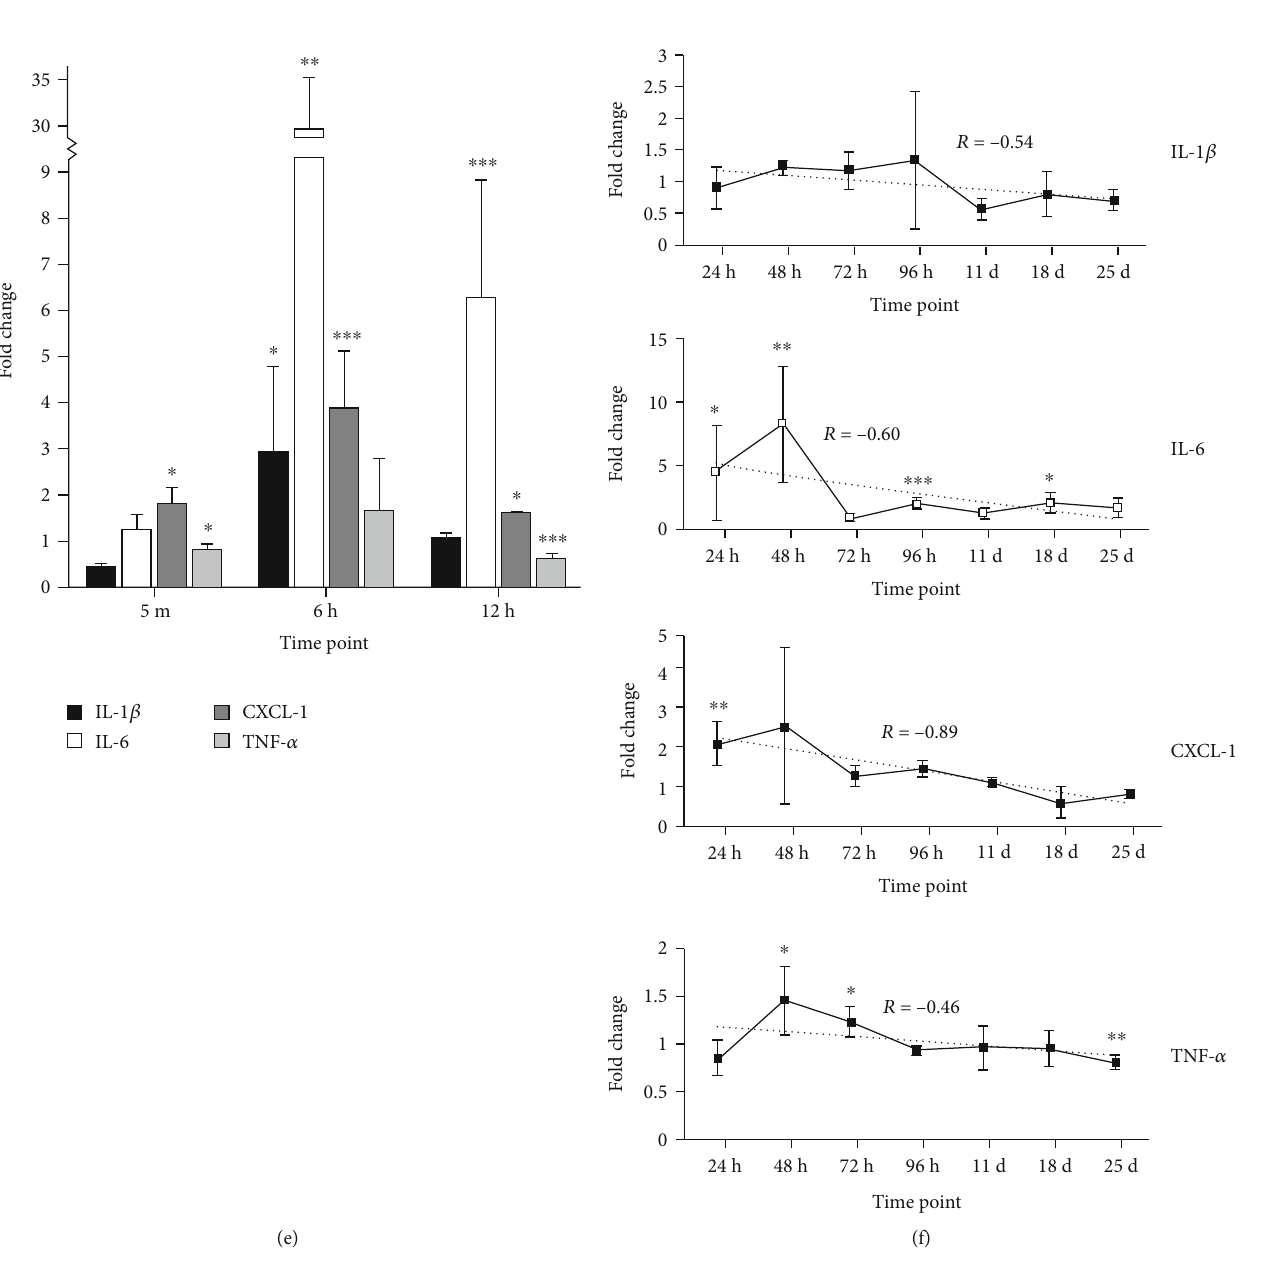
Figure 5: Blood cytokine concentrations of n = 3 mice euthanized at various time points following retroorbital inoculation of 250 million recombinant mouse IL-12-loaded PLGA nanospheres. Samples normalized to six control mouse cytokinomes and represented as fold change. For reference, a fold change of one (1) indicates equal cytokine levels in comparison to control, whereas a fold change of two (2) or one-half (0.5) indicates a respective doubling or halving from physiological levels. Tumor-destroying cytokines, IFN- γ , IL-2, and IL-5, were sampled at (a) the burst phase — 5 minutes (5 m), 6 hours (6 h), and 12 hours (12 h), and (b) the sill phase — 24 hours (24 h), 48 hours (48 h), 72 hours (72 h), 96 hours (96 h), 11 days (11 d), 18 days (18 d), and 25 days (25 d), postinoculation. Tumor-promoting, IL- 10, IL-4, and IL-5 (c, d), and SIRS-associated, IL-1 β , IL-6, CXCL-1, and TNF- α (e, f), cytokines are also displayed at the same time points, graphically separated into burst and sill phases. Statistical di ff erences were determined using Student ’ s t test. ∗ p < 0 : 05 , ∗∗ p < 0 : 01 , and ∗∗∗ p < 0 : 001